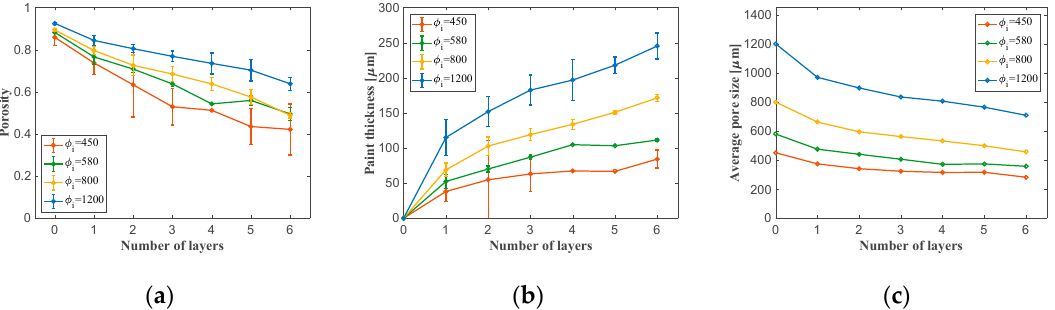
Figure 4. Variation of the ( a ) porosity, ( b ) paint thickness, and ( c ) average pore size with respect to the number of paint layers.